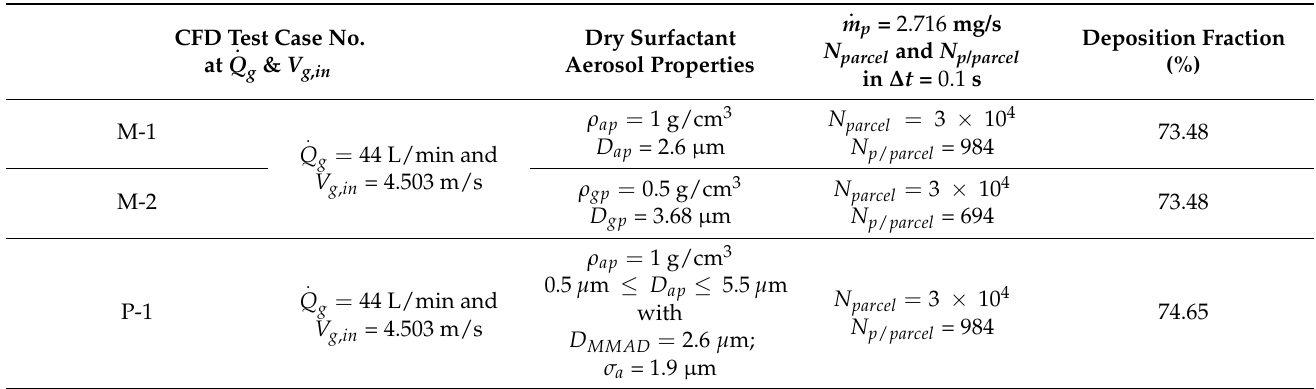
Table 1. CFD test case matrix of dry pulmonary aerosol deposition in the G0–G17 airways with the SST turbulence